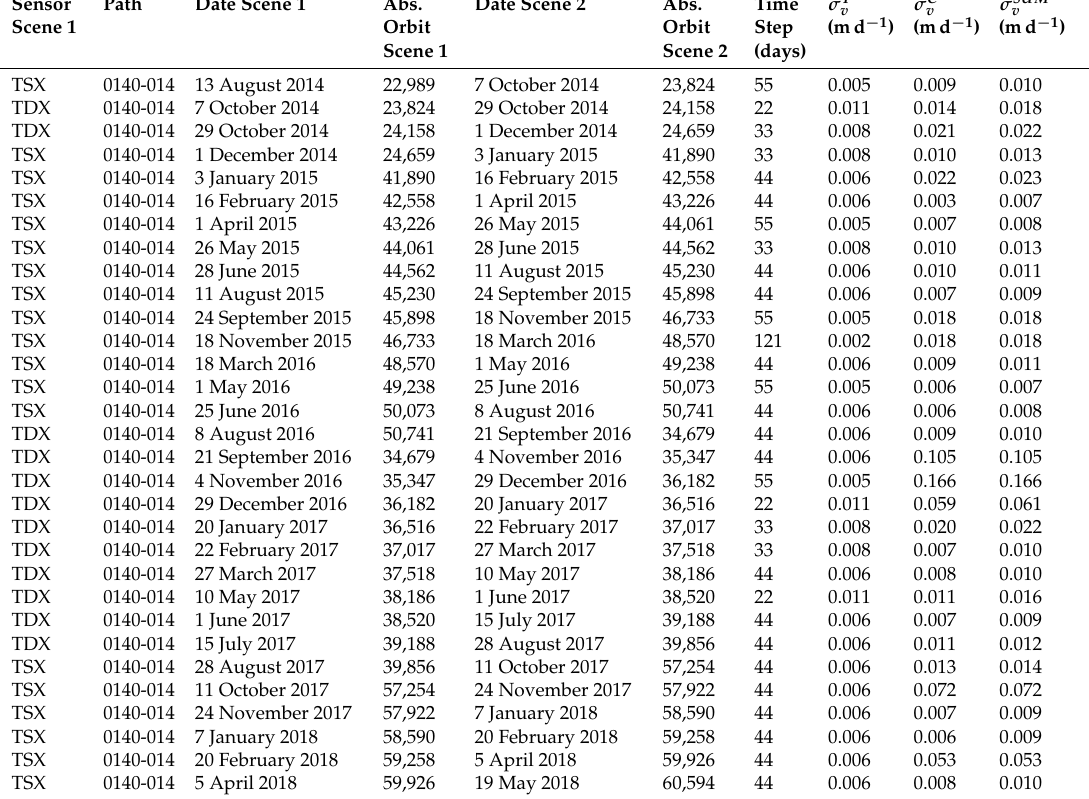
Table A1. Satellite scenes used as slave and master image in intensity feature tracking with aquisition dates, path and orbit informations, as well as the associated error estimates in md − 1 . σ T v is the error of the tracking algorithm, σ C v the co-registration error, and σ SUM v the square root of the quadratic sum of both [23].